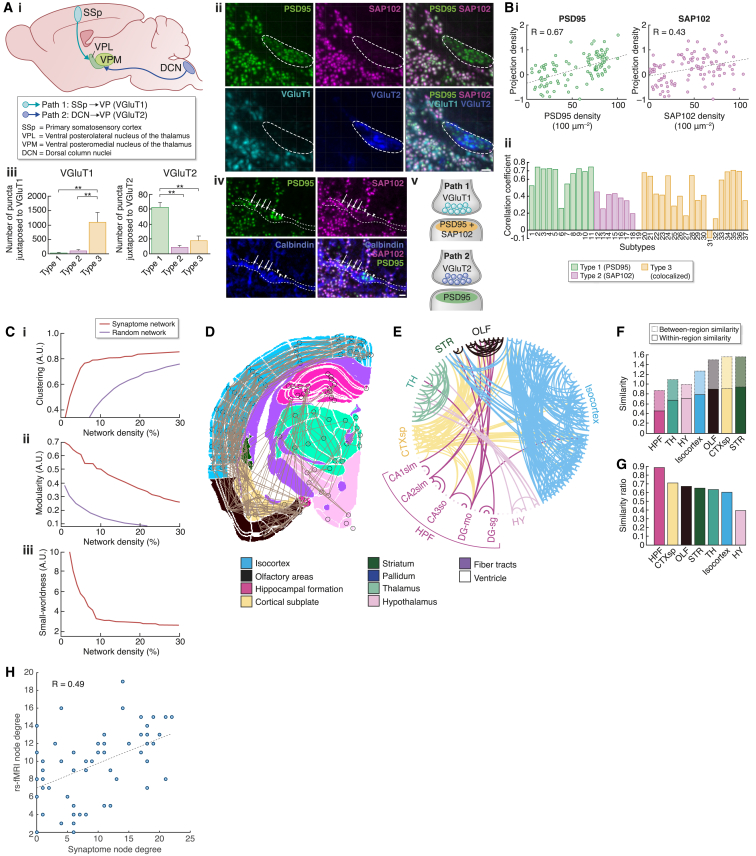
Synaptome and Connectome(Ai) Two main glutamatergic inputs to ventral posterior thalamus (VP) express VGluT1 and VGlut2 in their respective presynaptic terminals. Adapted from Graziano et al. (2008).(Aii) Co-labeling of PSD95 (green) and SAP102 (magenta) with presynaptic proteins VGluT1 (cyan) and VGluT2 (blue) in the VP. Scale bar, 1 μm.(Aiii) Quantification of PSD95-only (green), SAP102-only (magenta), or PSD95+SAP102 (orange) puncta juxtaposed to VGluT1 (left) or VGluT2 (right) (mean ± SD). ∗∗p < 0.01 post hoc Tukey.(Aiv) Co-labeling of PSD95 (green), SAP102 (magenta) and calbindin (blue) in VP. Arrows, colocalized synapses; arrowheads, PSD95-only synapses. Dashed lines delineate a calbindin-positive dendrite. Scale bar, 1 μm.(Av) Combinations of synaptic proteins define two connections: path 1, where VGluT1 contacts type 3 postsynaptic puncta (PSD95+SAP102); and path 2, where VGluT2 contacts type 1 postsynaptic puncta (PSD95 only).(Bi) Positive correlation (p < 0.05) between mesoscale maximal normalized projection density and PSD95 (left) and SAP102 (right) regional punctum densities.(Bii) Correlation coefficients between densities of 37 synapse subtypes and the mesoscale connectome projection density.(C) Synaptome network topology. Clustering coefficient (i), modularity (ii), and small-worldness (iii) of the synaptome network and random network.(D) Most significant connections (gray lines) between subregions (black circles) in section 3.(E) Circular graph of the 5% most significant connections of the binarized similarity between brain regions in section 3.(F) Between-region and within-region similarity of synaptome parameters for each overarching area from section 3.(G) The ratio of within-region to between-region similarities for synaptome parameters for areas in (F).(H) Correlation between synaptome and resting-state fMRI connectome node degree. Dots represent brain subregions. Correlation coefficient is shown (p < 0.0002).